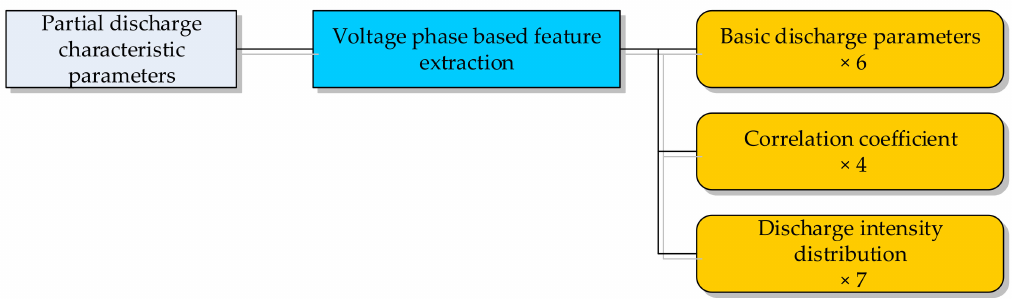
Figure 4. Features used in this